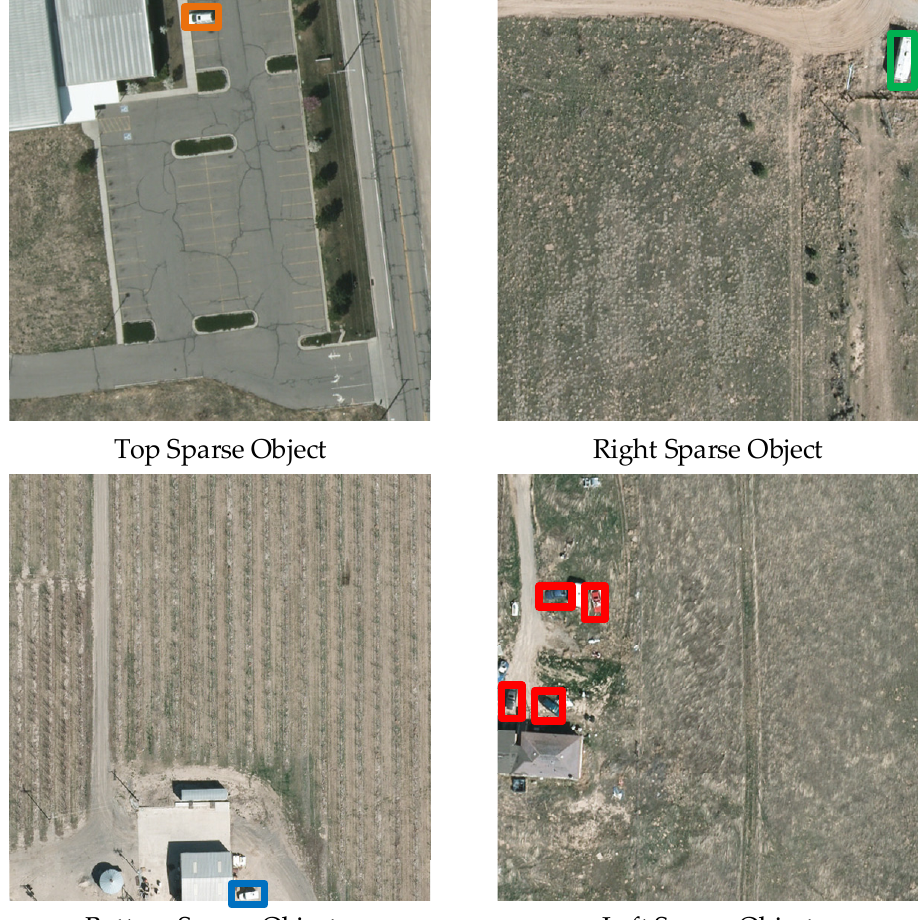
Figure 4. Sparse object distribution.